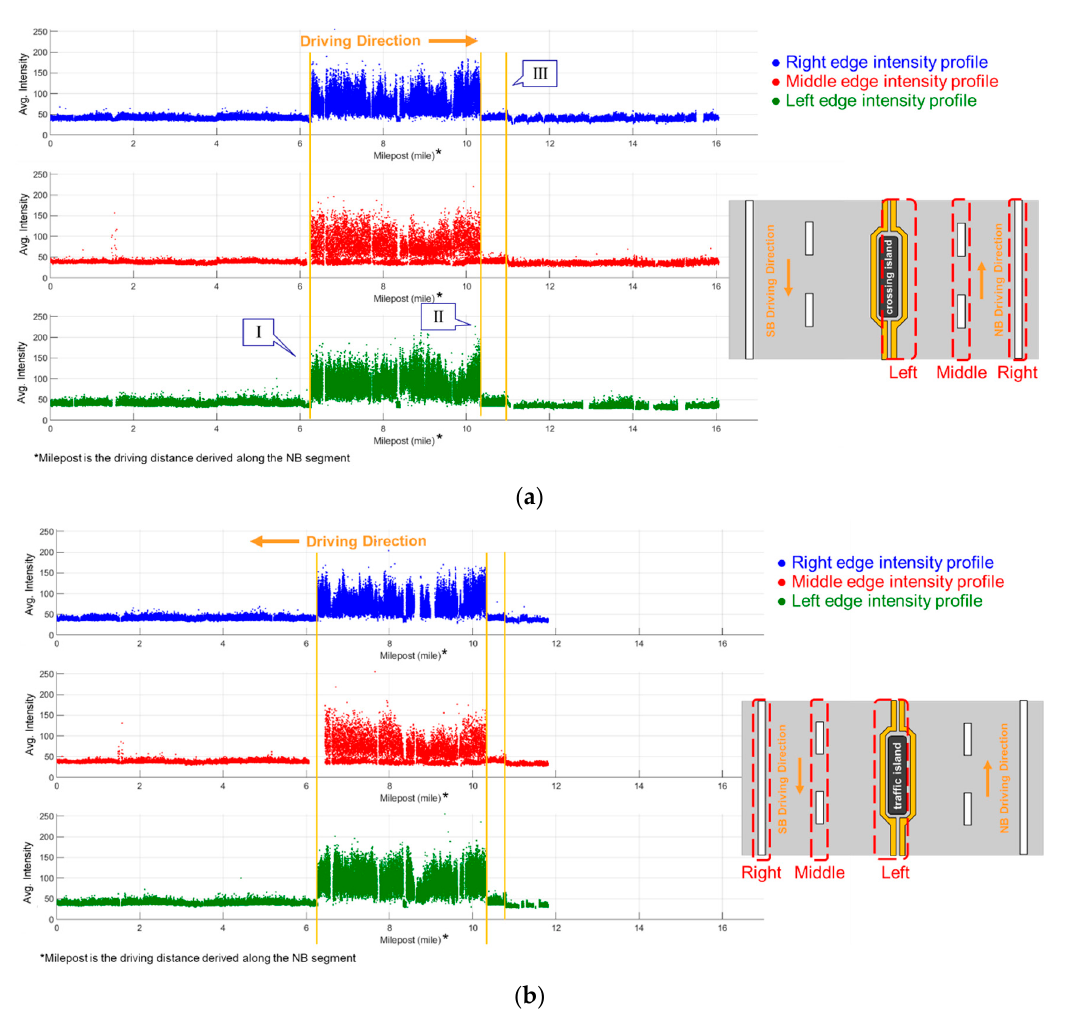
Figure 23. Intensity profiles (right, middle, and left edges) with similar changes (highlighted by yellow lines) for ( a ) NB and ( b ) SB segments.